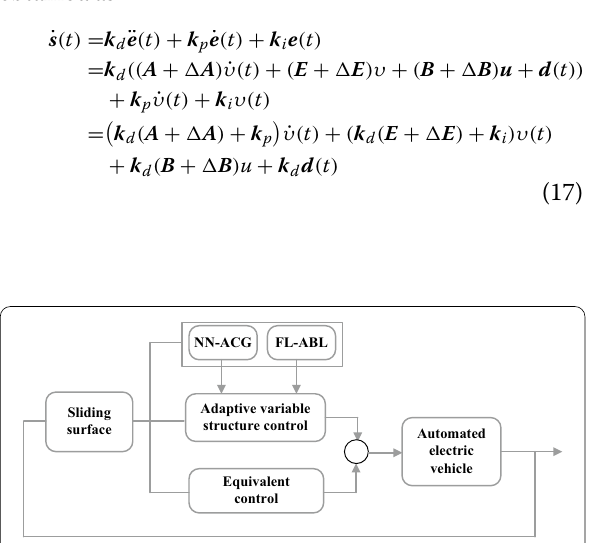
Figure 3 Neural-fuzzy-based adaptive sliding mode automatic steering control